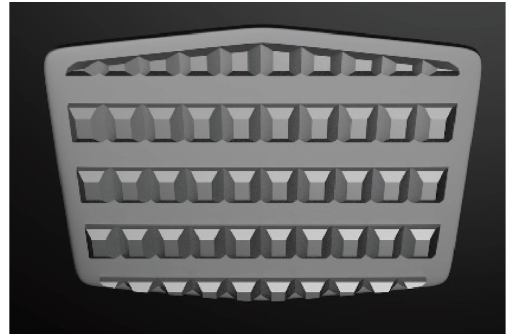
Figure 3: Retention grooves